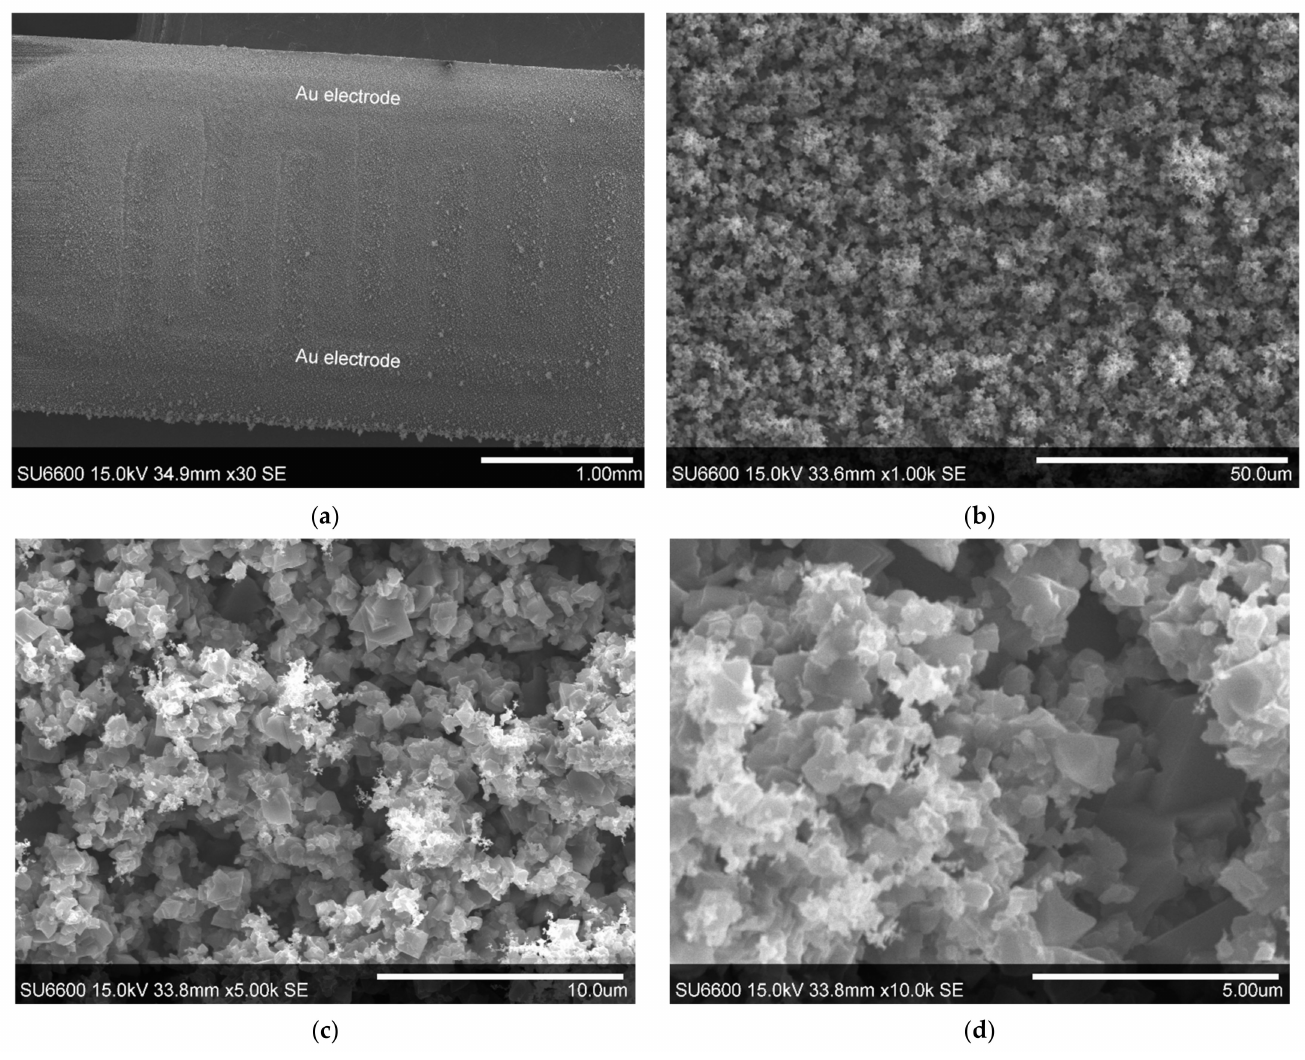
Figure 3. Microstructure of the surface of gallium oxide epitaxial layer: ( a ) under × 30 magnification. Gold interdigitated electrodes are visible under the epitaxial layer; ( b ) under × 1000 magnification; ( c ) under × 5000 magnification; ( d ) under × 10,000